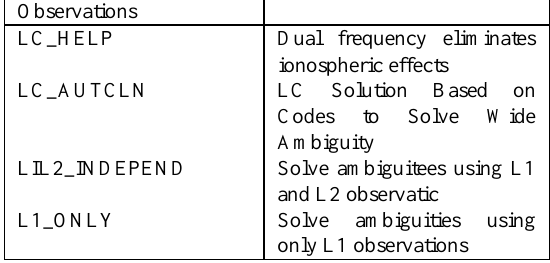
Table 2. Selection of observations